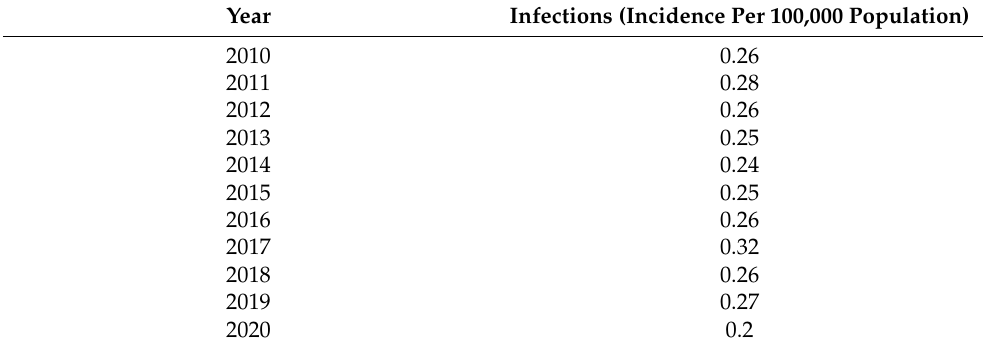
Table 6. FoodNet data for Listeria infections by year.